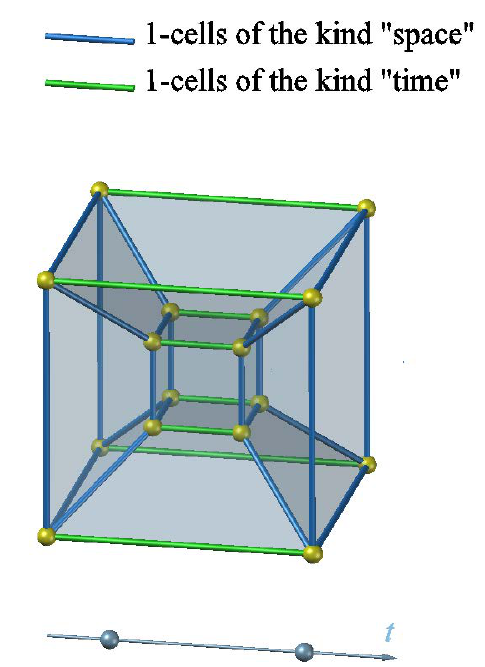
Figure 66: Different kinds of 1-cells in a space/time tesseract.